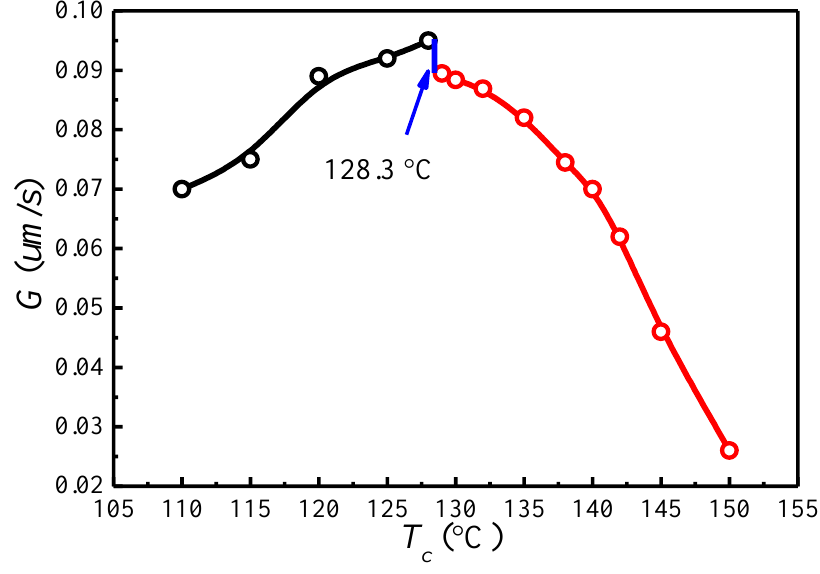
Figure 8. The PLLA spherulite growth rates ( G ) as a function of crystallization temperature ( 𝑇 c ).